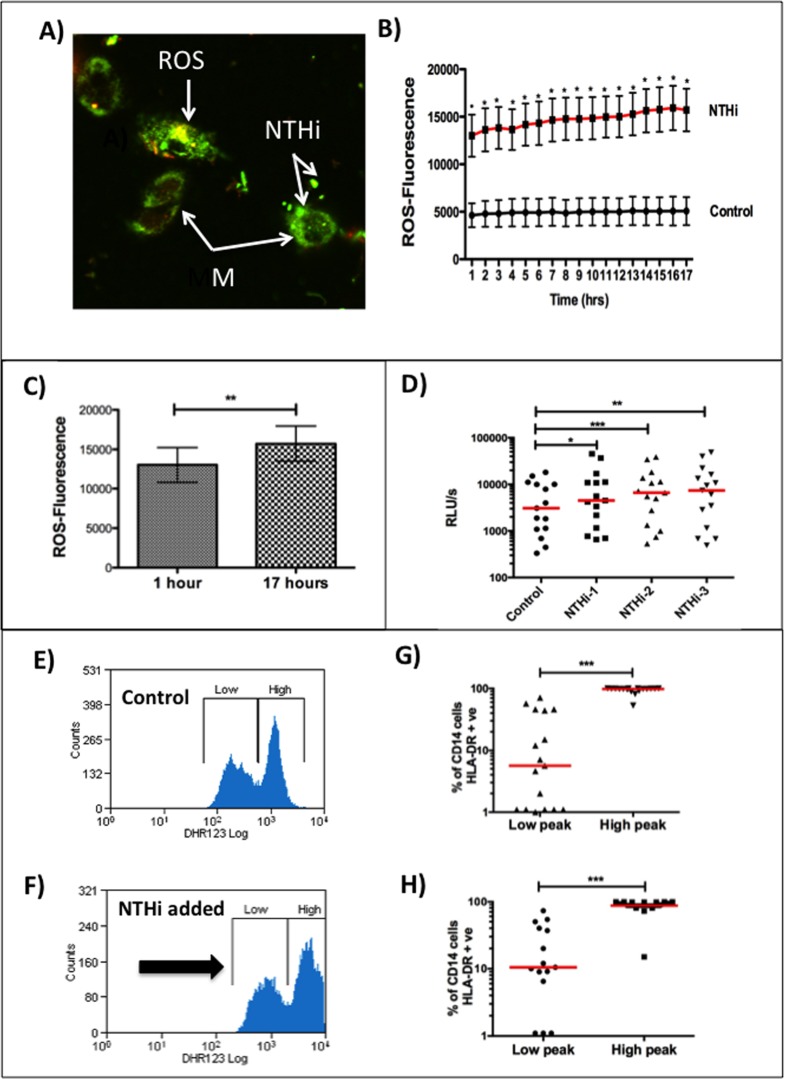
Response by human bronchoalveolar macrophages to nontypeable Haemophilus influenzae.Panel A shows adherent BAL macrophages with staining for NTHi and production of ROS fluorescence in macrophages infected with NTHi by confocal microscopy. Panel B shows the ROS production in control (uninfected) macrophages and NTHi-infected macrophages over a 17 hour time-period (n = 15 subjects for each time-point) measured by confocal microscopy. At each one-hour time-point ROS production is significantly higher in the NTHi group (p<0·01). Panel C shows the increase over 17 hours in ROS production (1 hour 13012±2214, 17 hours 15175±2247)), (n = 15, p = 0·009). Panel D shows upregulation of ROS as measured by the effect of three different strains of NTHi using chemiluminescence (control 5937 (1839–10855), NTHi-1 8193 (3569–15538), NTHi-2 8953 (5105–17111), NTHi-3 10093 (4136–20848)), (RLUs = reactive light units/second). The chemiluminescence predominantly measures extracellular ROS production. Panels E and F demonstrates an examples of the presence of high and low-producing ROS fluorescence populations in control (unstimulated) and NTHi-stimulated macrophages from a patient (using flow cytometry). The high-producing ROS populations have significantly increased surface expression of the M1 marker HLA-DR (p<0·001): Panel G shows the unstimulated (baseline) macrophage population (low peak 6 (1–45), high peak 98 (94–99)), (n = 17), whilst Panel H shows the NTHi-stimulated macrophage population (low peak 11 (7–40), high peak 95 (80–100)), (n = 15).